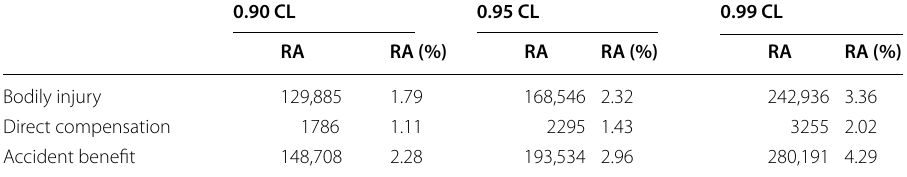
Table 15 Risk adjustments using CoC